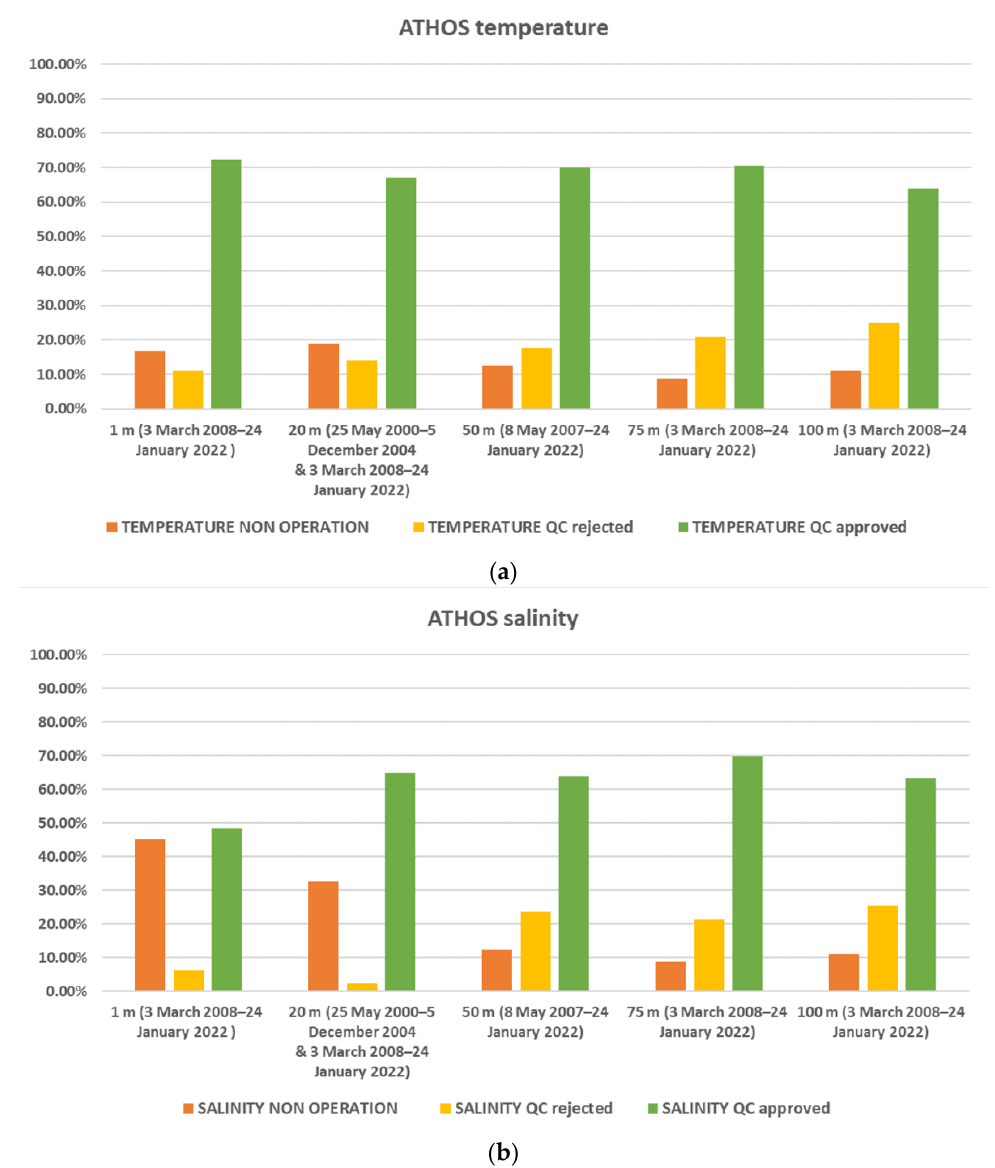
Figure 15. ATHOS percentage of the quality approved data, the rejected data during quality control (QC) as well as the percentage of non-operation period of the station or sensors for temperature ( a ) and salinity ( b ).